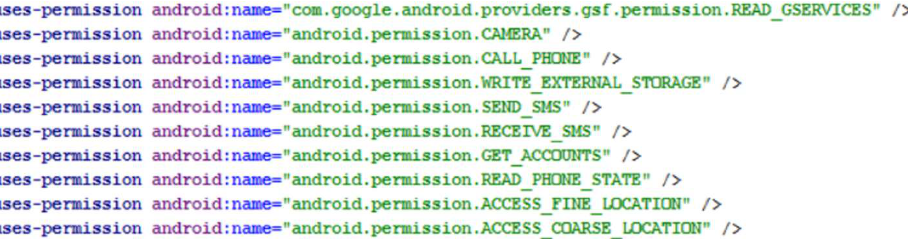
Figure 1. AndroidManifext.xml showing permissions.